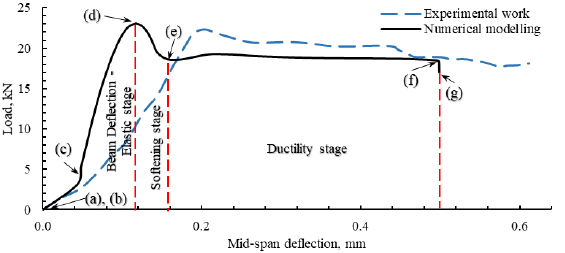
Fig. 12. Load-displacement profile from XFEM-CZM results (beam series